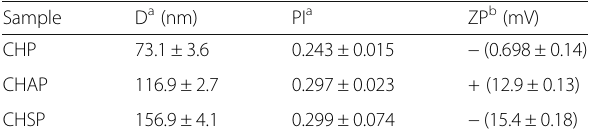
Table 1 Zeta potential and size distribution of CHP, CHAP, and CHSP